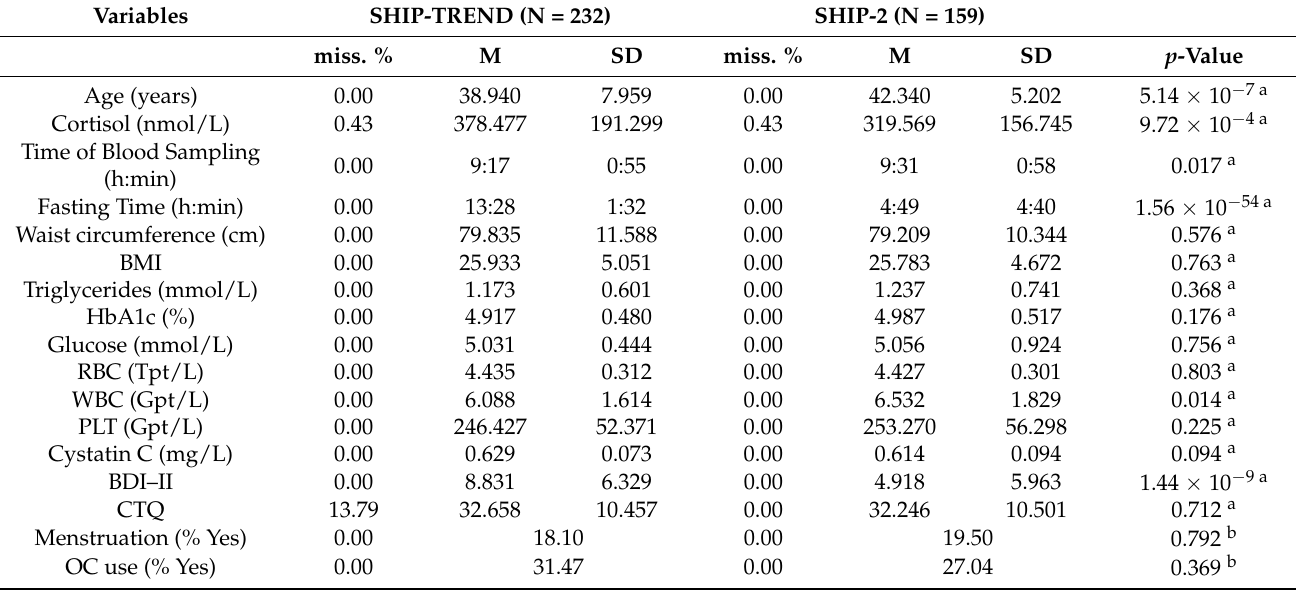
Table 1. Descriptive statistics for the SHIP–TREND and SHIP–2 study cohorts.